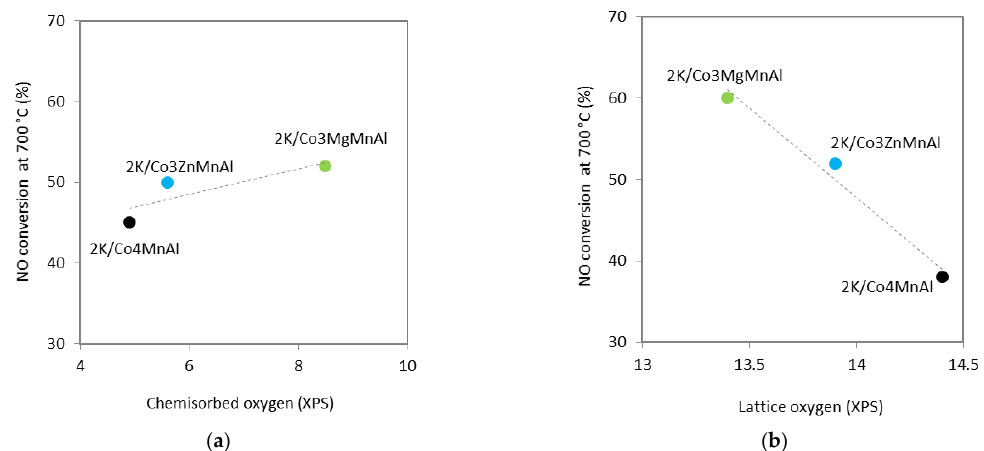
Figure 15. Dependence of NO conversion on: ( a ) chemisorbed and ( b ) lattice oxygen. As a result of the different cobalt content in the samples, the turnover frequency (TOF) was used for the comparison of the activity. The TOF was calculated using the Co amount as the number of active sites since the samples containing manganese instead of cobalt were non-active (unpublished results — manuscript in preparation). The TOF which related to 1 g of cobalt (Table S3) had the same trend as the NO conversion (Figure 16a). Different TOF values indicate that the achieved value of the NO conversion is influenced by the specific surface area and the number of achievable active sites on the catalyst ’s surface which are associated with it. From the direct correlation between the NO conversion and TOF on the temperature of the O 2 desorption during TPD-NO (Figure 16b), it can be seen that the decisive parameter is also the thermal stability of the reaction intermediates affected by the redox properties given by the chemical composition of the catalysts. Here, the most important is the optimal potassium promoter content, without which the NO decomposition practically does not carry on [15,33,37]. The onset of the desorption of O 2 was observed at the lowest temperature for the most active 2K/Co3MgMnAl mixed oxide catalyst. This finding may indicate that an oxygen desorption through the decomposition of surface nitrite is a crucial step in being in agreement with [33,51,69,71].